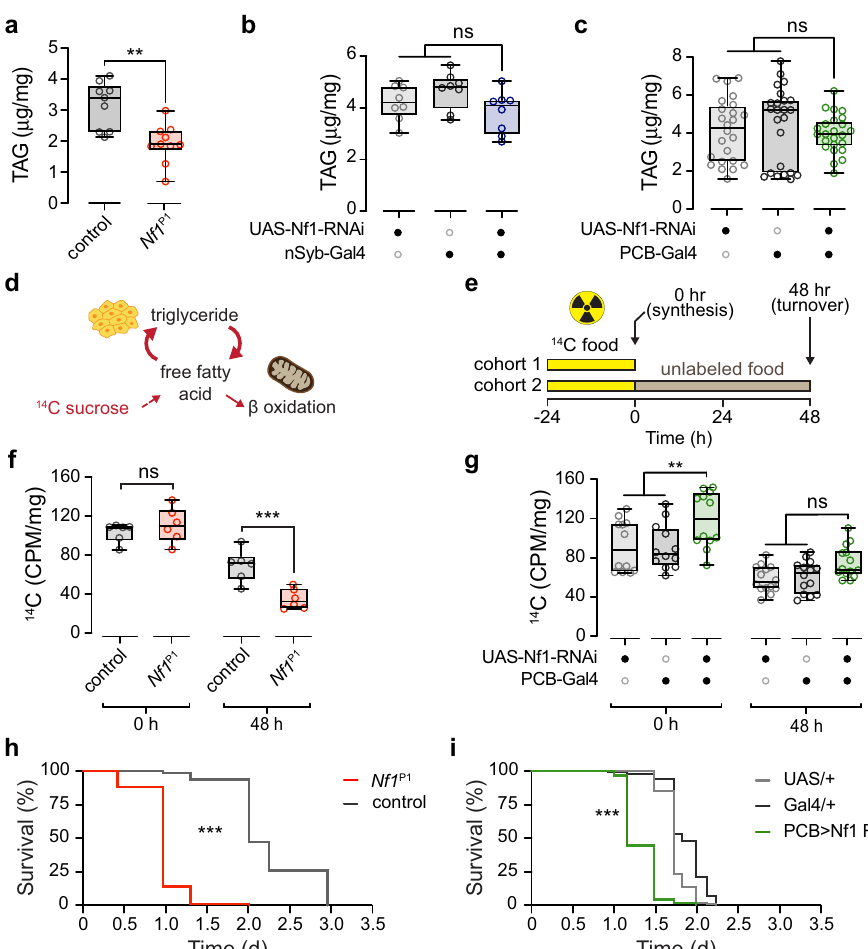
Fig. 5 Loss of Nf1 reduces starvation resistance and alters lipid stores and turnover kinetics. a Quanti fi cation of total body triglyceride (TAG) content in Nf1 P1 mutants ( n = 9) and w CS10 controls ( n = 10). ** p = 0.002 (Mann – Whitney, two-sided). b Quanti fi cation of total TAG content of